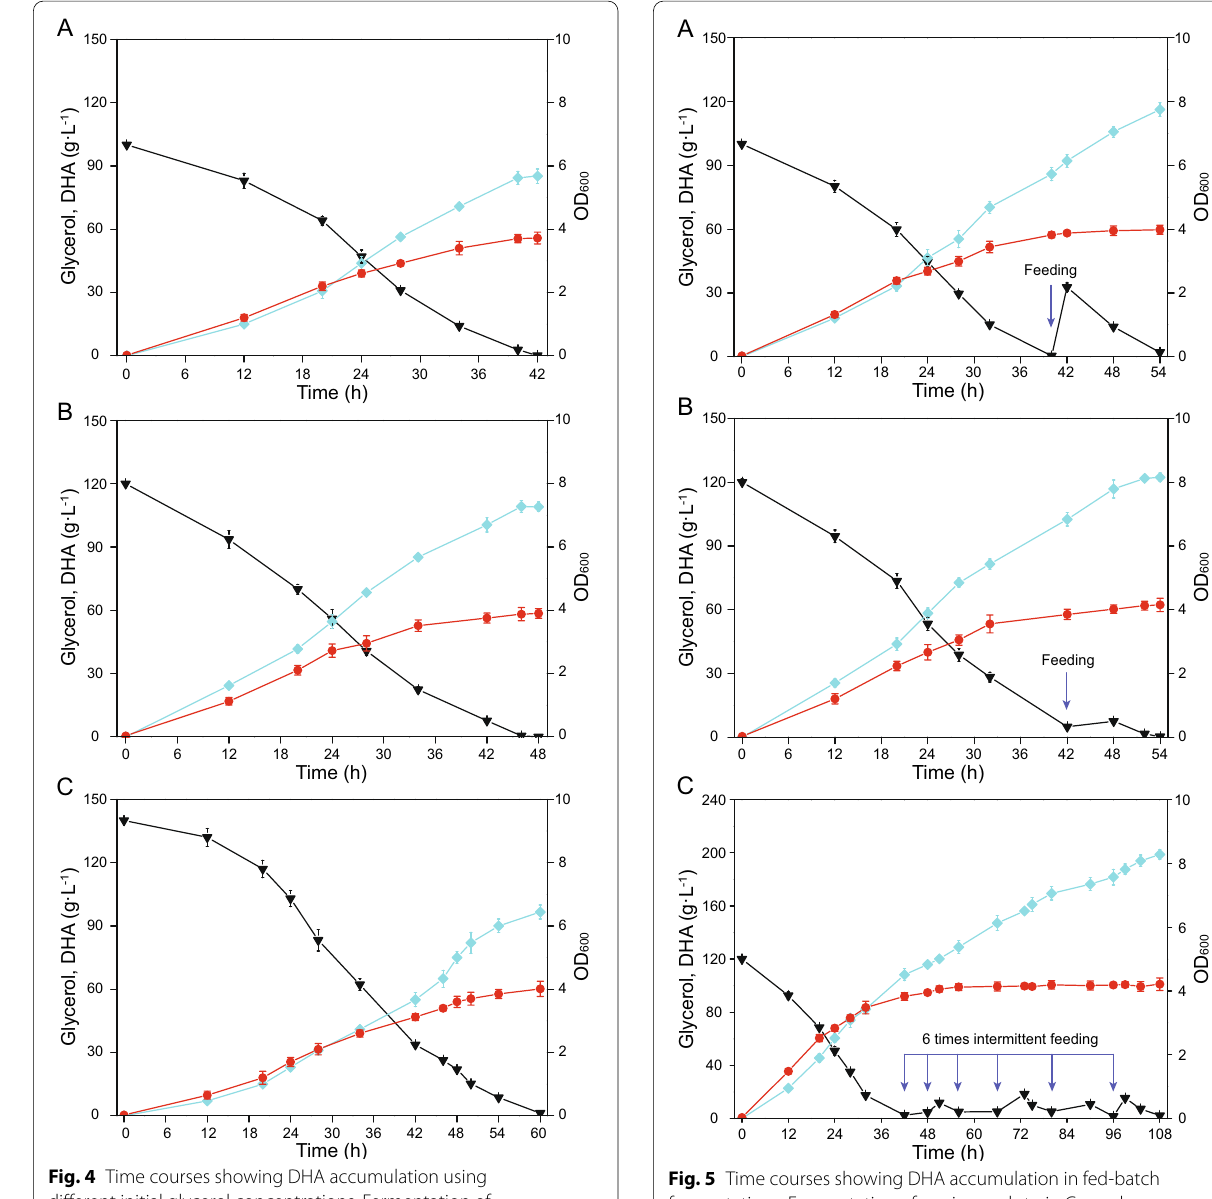
was < 5 g L − 1 . The process, using an initial 100 g L − 1 glycerol and feeding 40 g L − 1 at 1 time, was as a control. The process that using an initial 120 g L − 1 glycerol and